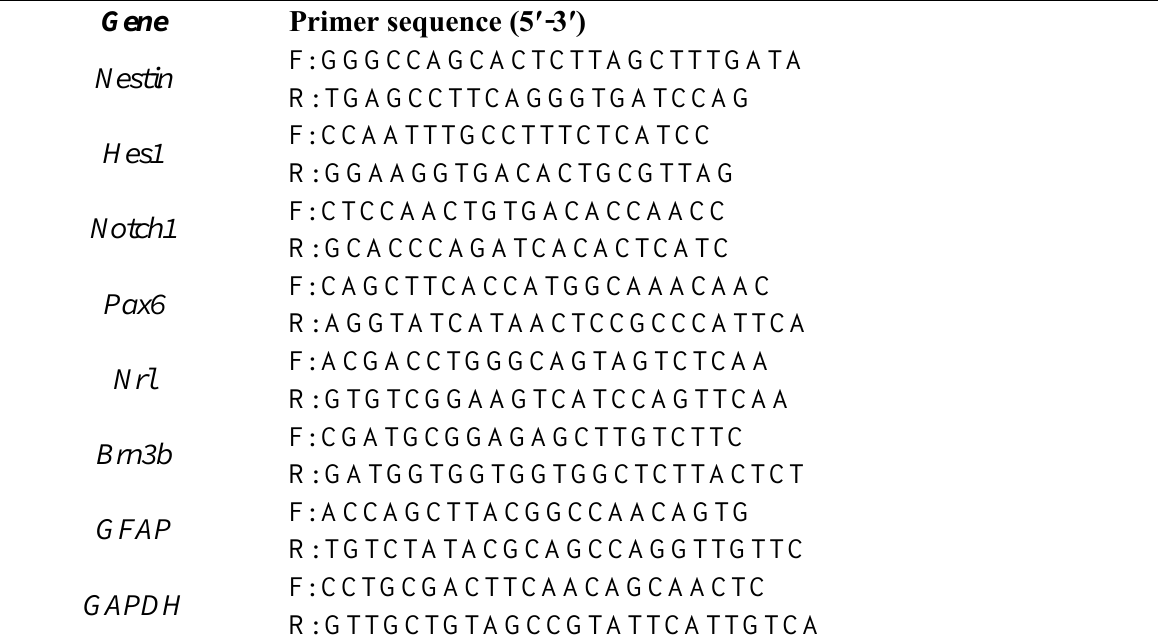
Table 1. Sequence of primer pairs used in real-time quantitative